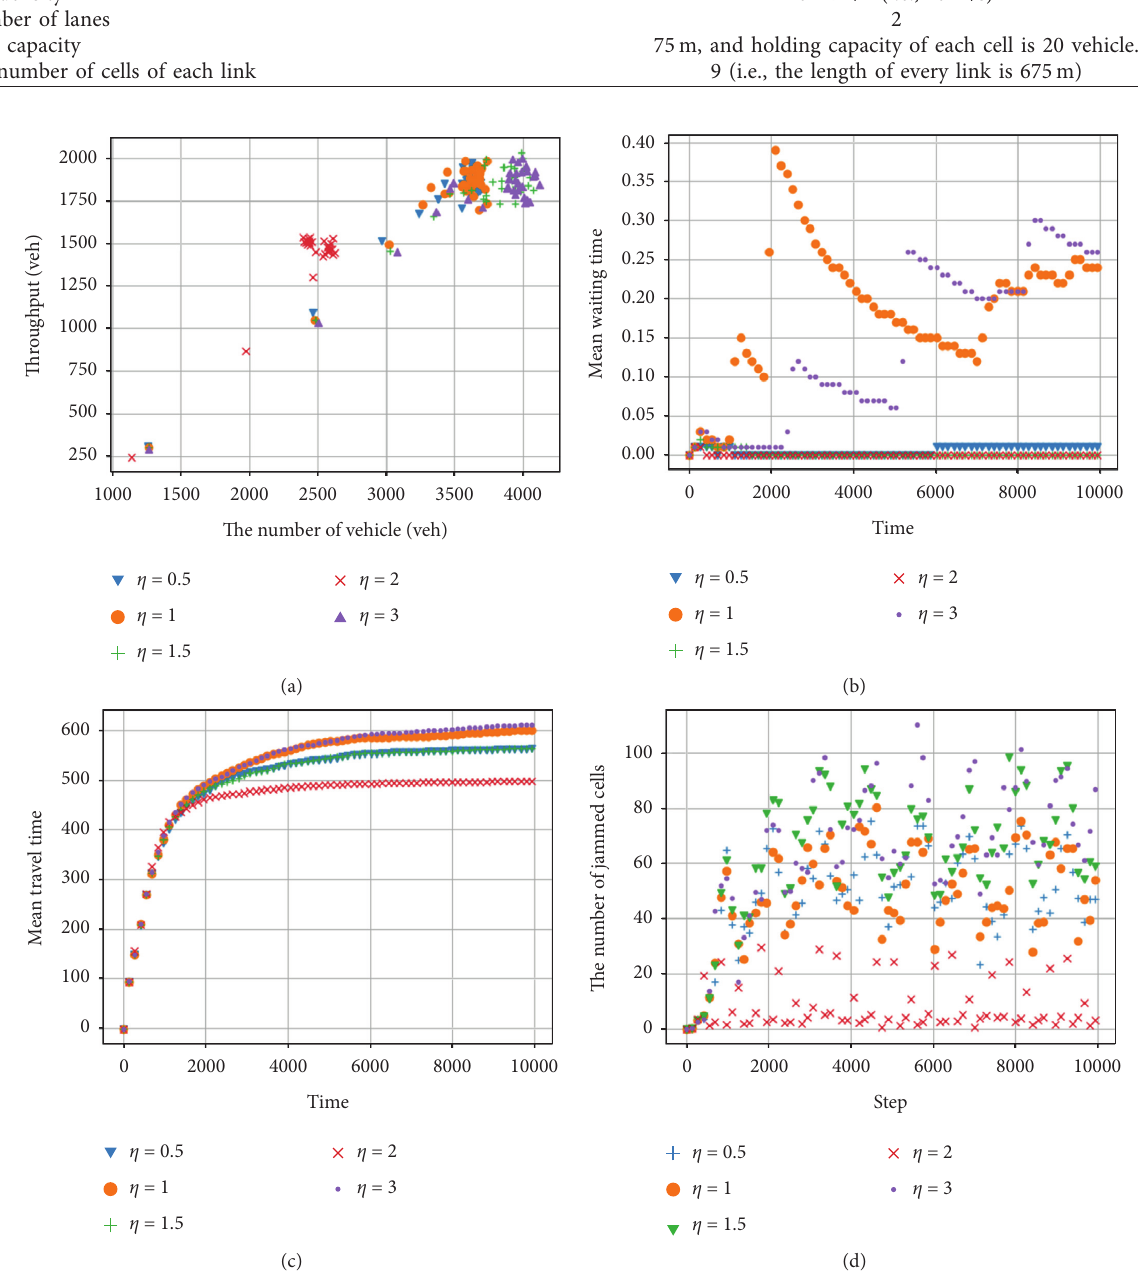
Figure 7: The network evaluation using different values of η � 0.5, 1, 1.5, 2, 3 of an 8 × 8 network with one strategy for Γ � 1. These images compare the simulation results of different η . As can be seen, η � 2 is the well configuration of our model. (a) The network throughput. (b) The average waiting time. (c) The average travel time. (d) The number of jammed